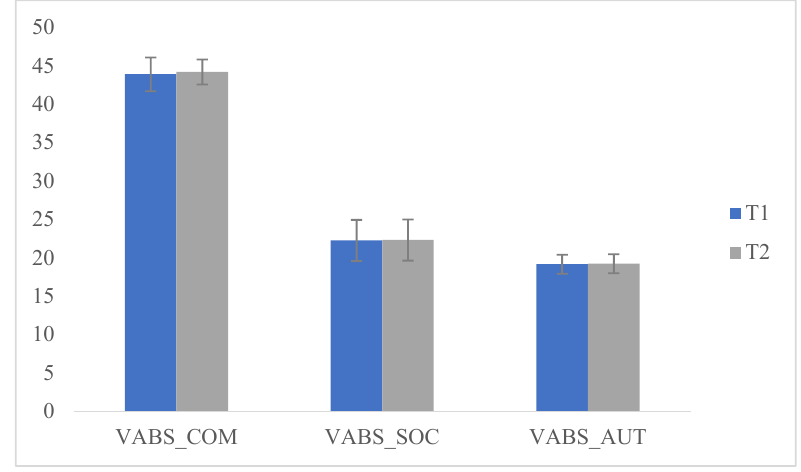
Figure 3. Comparisons VAB, T1 and T2 .